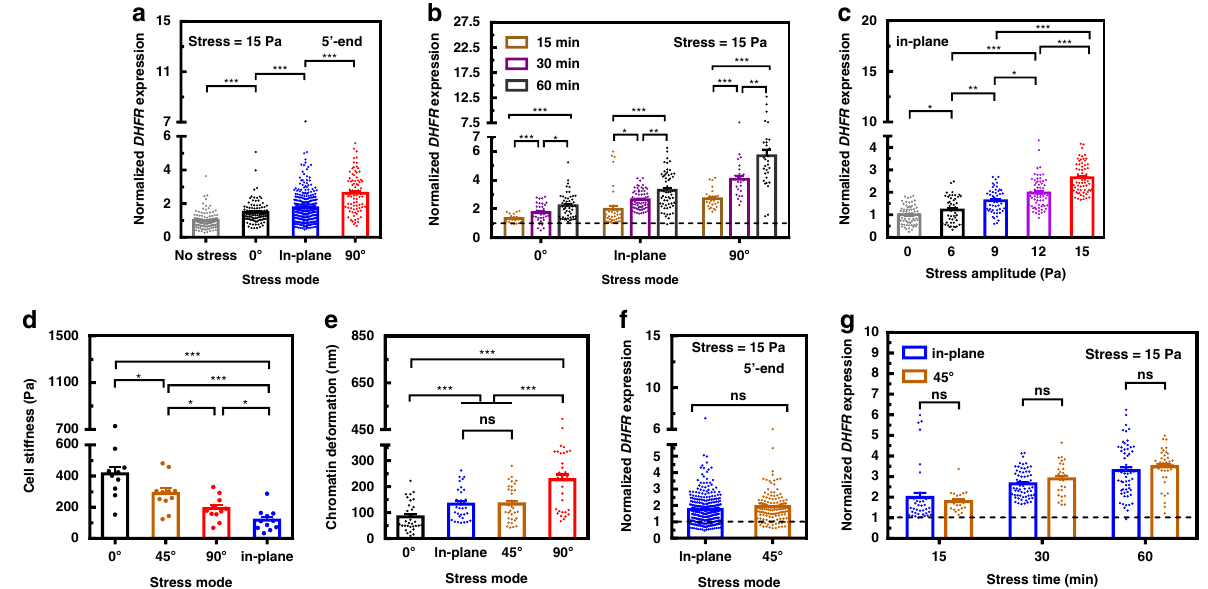
Fig. 3 Transcription varies with stress modes and increases with stress duration. a Summarized data of DHFR transcription detected with 5 ′ -end probes. Stress was applied to each cell only once at one particular angle for all FISH experiments. Fluorescently labeled 5 ′ -end probes were used to detect expression of the fi rst 1700 bps DHFR mRNA. Controls (No stress) were the cells in the same dish without attachment of magnetic beads. The stress was applied for 2 min at 15 Pa and 0.3 Hz. P < 0.001 between each different stress modes. Mean± s.e.m.; n = 115, 97, 344, and 85 cells for no stress, 0°, in- plane, and 90° stress modes, respectively, in nine separate experiments; *** P < 0.001. b DHFR transcription upregulation depends on stress (15 Pa at 0.3 Hz) duration for both in-plane and out-of-plane modes. P = 0.016 between 30 and 60 min under 0° stress mode; P = 0.025 between 15 and 30 min and P = 0.0015 between 30 and 60 min under in-plane stress mode; P = 0.0039 between 30 and 60 min under 90° stress mode; P < 0.001 between other conditions under each stress mode. Mean± s.e.m.; 0°: n = 21, 33, and 52 cells at 15, 30, and 60 min; in-plane: n = 38, 66, and 60 cells at 15, 30, and 60 min; 90°: n = 26, 25, and 32 cells at 15, 30, and 60 min. Three independent experiments. * P < 0.05; ** P < 0.01; *** P < 0.001. The dashed line was the no stress control. c DHFR gene upregulation depends on stress amplitudes of the in-plane mode. All stresses were applied at 0.3 Hz for 30 min. n = 71 cells for 0 stress; n = 47, 50, 68, and 66 cells at 6, 9, 12, and 15 Pa, respectively. P = 0.032 between 0 stress and 6 Pa; P = 0.0033 between 6 and 9 Pa; P = 0.014 between 9 and 12 Pa; P < 0.001 between other different stress amplitudes. Mean ± s.e.m.; * P < 0.05; ** P < 0.01; *** P < 0.001. d Cell stiffness computed from different stress modes. P = 0.036 between 0° and 45° stress modes; P = 0.039 between 45° and 90° stress modes; P = 0.037 between 90° and in-plane stress modes ; P < 0.001 between 0° and in-plane stress modes as well as 45° and in-plane stress modes. Mean± s.e.m.; n = 11 cells, eight independent experiments. * P < 0.05; *** P < 0.001. e Chromatin deformation (chromatin deformation, i.e., changes of distance between GPF spots) with different stress modes. No difference was found between the 45° mode and the in-plane mode. P = 0.97 between in-plane and 45° stress modes; P < 0.001 between other different stress modes. Mean ± s.e.m.; n = 33 GFP spots; 11 cells, eight independent experiments. *** P < 0.001; ns = not signi fi cantly different. f Comparison and 0.3 Hz. P = 0.069 between in-plane and 45° stress modes. Mean ± s.e.m.; n = 344 and 140 cells for in-plane and 45° stress modes; nine separate experiments; ns = not signi fi cantly different. The dashed line was the baseline transcription level in the absence of force. g DHFR upregulation was similar at longer durations of stress (15 Pa and 0.3 Hz) between the 45° out-plane mode and the in-plane mode. P = 0.44, 0.14, and 0.4 between in-plane and 45° stress modes under 15, 30, and 60 min, respectively. Mean ± s.e.m.; 45°: n = 21, 29, and 39 cells at 15, 30, and 60 min, respectively; in-plane: n = 38, 66, and 60 cells at 15, 30, and 60 min, respectively. Three independent experiments; ns = not signi fi cantly different. The dashed line was the baseline transcription level in the absence of force. P values were calculated and corrected using two-tailed Student ’ s t -test and Bonferroni correction. Source data are provided as a Source data fi